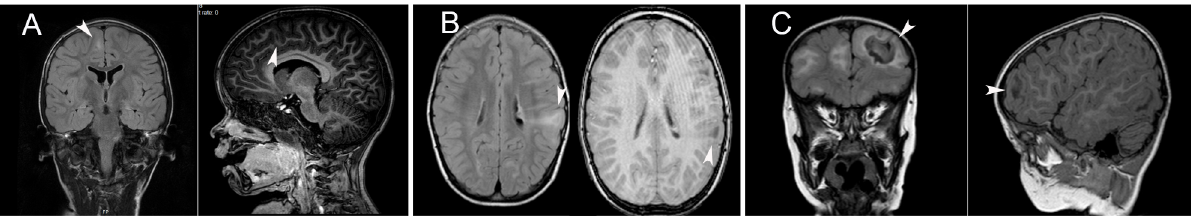
Fig 5. Clinical implications. A. Representative MRI of a patient with a histological type A tuber (histology is shown in Fig 1B) characterized by a hyperintense lesion parasaggital in the right frontal lobe (indicated by the arrow head) on T2 weighted and fluid-attenuated inversion recovery (FLAIR) and a hypointense signal in the same area on volumetric T1 images. B. MRI of a histological type B tuber (histology is shown in Fig 1C) with FCD-like features in the left postcentral/parietal region, showing as a hyperintense lesion on FLAIR image and a hypointense signal on 3DT1. FCD features are recognized by thickened cortex, blurring of gray and white matter junction and a transmantal sign. C. MRI of a histological type C tuber (histology is shown in Fig 1D) with a large calcification, characterized by deep hypointense signal with surrounding heterogenous hyperintense signal on T2 weighted and FLAIR images and a hypointense signal in the white matter on 3DT1. The above described FCD features are seen here as well.